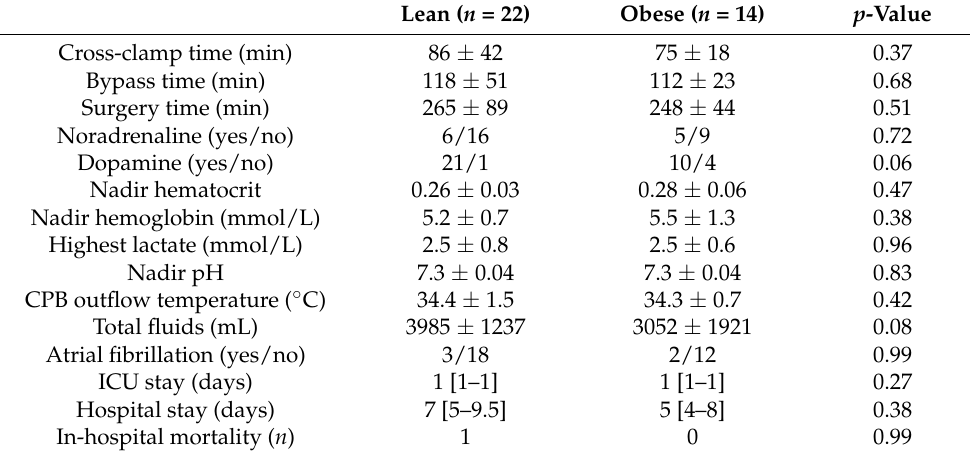
Table 3. Intraoperative parameters and postoperative